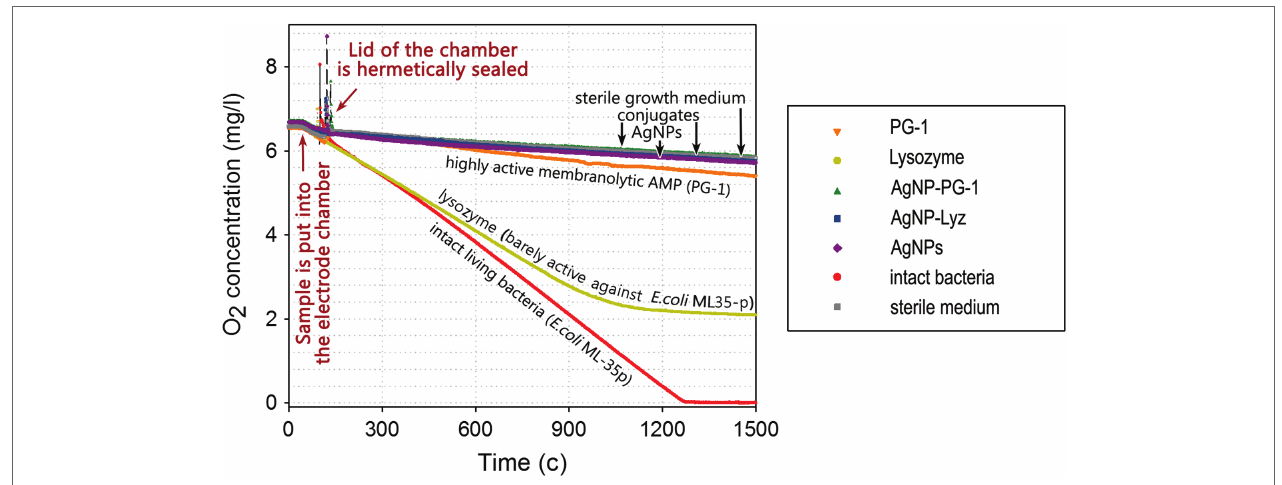
FIGURE 3 | Dynamics of the consumption of O 2 dissolved in the growth medium by E. coli ML-35p. Molecular oxygen consumption was measured in the presence of AgNP-AMP/AP conjugates or antimicrobial peptides and proteins (AMPs and APs) and gelatin-only coated silver nanoparticles (AgNPs) alone. The concentration of dissolved oxygen was measured using an Oxigraph Plus Clark-type electrode unit with hermetically sealed lid (Hansatech Instruments ltd, UK). The concentration of antimicrobials in the test mixture was equal to 4 × MIC (minimal inhibitory concentration); typical curves are shown.